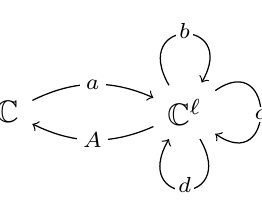
Figure 13 . The quiver with relations reproducing the threefold family of deformed E 6 ; E 7 ; E (5) ; E (6) surface singularities admitting a simultaneous resolution, with ‘ = 3 ; 4 ; 5 ; 6 re- 8 8 spectively (equal to the label of the black node in the corresponding non-a(cid:14)ne Dynkin of (cid:12)gure 7).